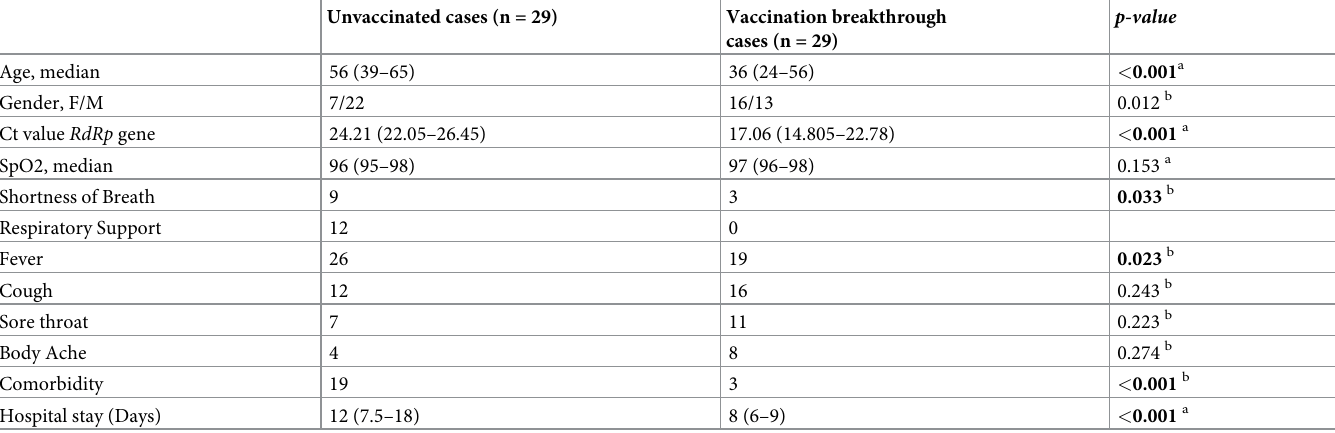
Table 1. The demographic details and clinical parameters for unvaccinated and vaccination breakthrough cohort of patients.